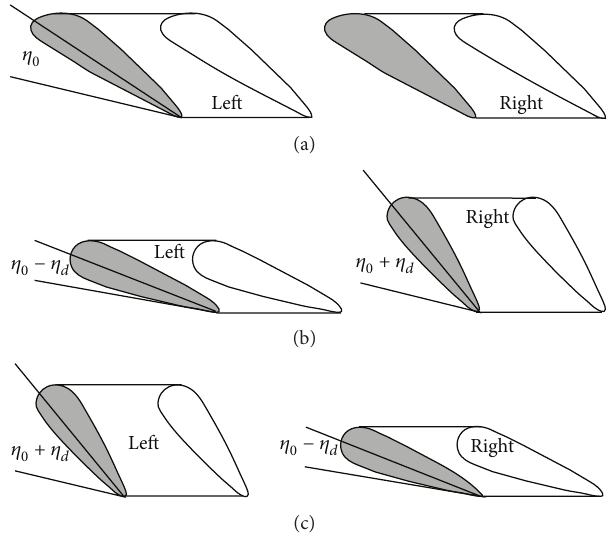
Figure 3: (a) Collective MHT angle, (b) left negative and right pos- itive differential MHT angles, and (c) right negative and left positive differential MHT